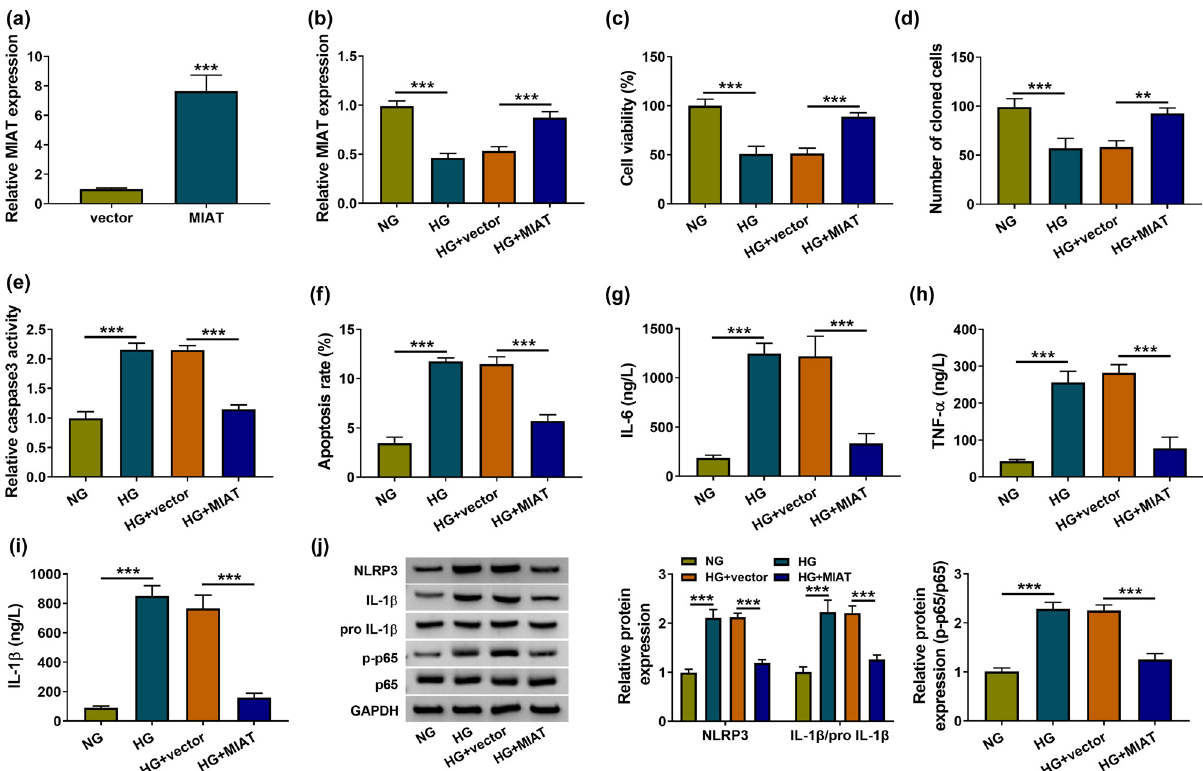
Figure 2: MIAT reestablishment antagonized the HG - induced cell damages and HG - activated NF - κ B pathway in HK - 2 cells. ( a ) MIAT expression was detected by RT - qPCR in HK - 2 cells transfected with vector or MIAT. ( b ) The RT - qPCR was applied for MIAT level analysis after treatment of NG, HG, HG + vector, or HG + MIAT in HK - 2 cells. ( c – f ) Cell viability ( c ) , colonizing capacity ( d ) , and apoptosis ( e – f ) were examined using CCK - 8, colony formation assay and caspase - 3 activity detection/ fl ow cytometry, respectively. ( g – i ) The determination of IL - 6, TNF - α , and IL - 1 β was completed by ELISA. ( j ) Western blot was used to analyze NLRP3, IL - 1 β /pro - IL - 1 β , and p - p65/p65 proteins. ** P < 0.01, *** P <